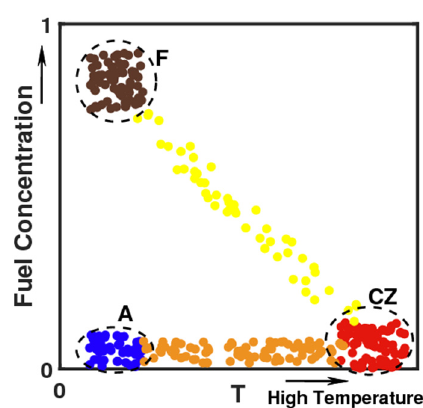
Figure 2. Schematic diagram of clustering using scatters of temperature and fuel concentration as an example. Colors of five clustering classifications will be identified later, and the three abbreviations, “CZ”, “A” and “F”, stand for combustion zone, air and fuel, respectively.